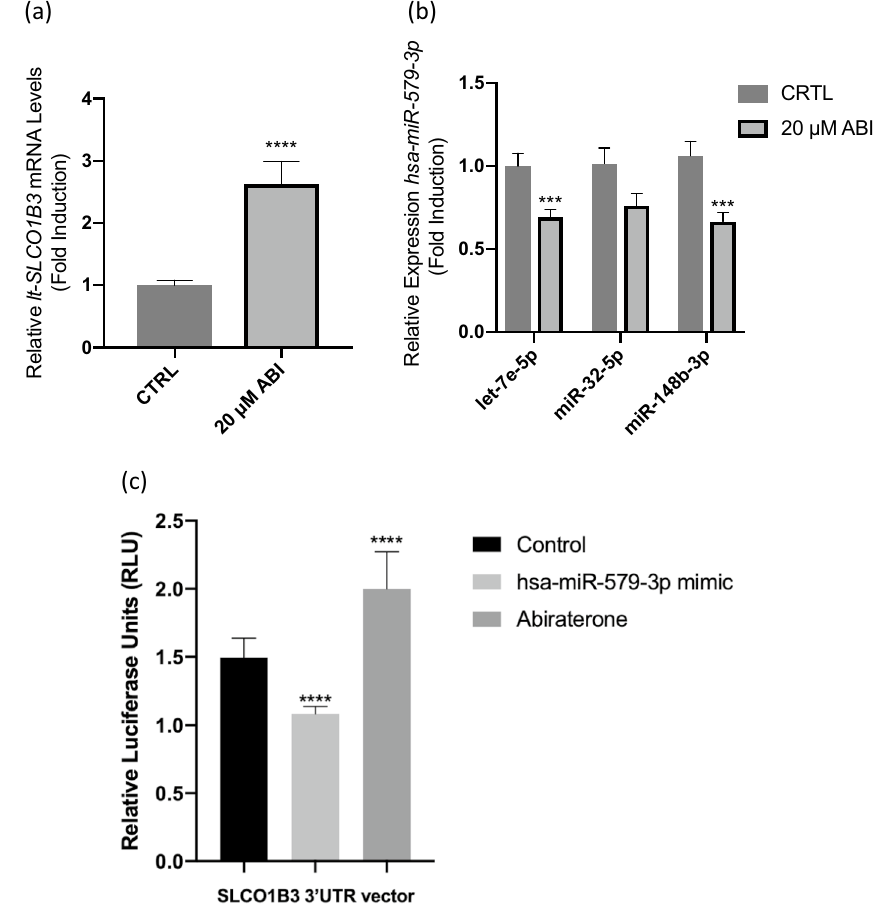
Figure 5. Abiraterone induces overexpression of lt-SLCO1B3 while suppressing hsa-miR-579-5p expression. Effects of abiraterone treatment on the expression of ( a ) lt-SLCO1B3 and ( b ) hsa-miR-579-3p in the samples processed for NanoString analysis were validated by qPCR analysis. As expected hsa-miR-579-3p expression was reduced and lt-SLCO1B3 expression was increased following abiraterone treatment, consistent with miRNA- transcript repression. ( c ) hsa-miR-579-3p directly binds to SLCO1B3 3 ′ UTR. Co-transfection of 22Rv1 cells was performed with the 3 ′ UTR reporter plasmid (or vector control plasmid) and hsa-miR-579-3p mimic (or negative control mimic) for 24 h followed by luciferase reporter assays. The assay revealed a significant decrease in SLCO1B3 reporter activity in the presence of the mimic. 22Rv1 cells were also transfected with the 3 ′ UTR plasmid (or vector control plasmid) followed by treatment with 20 µM Abiraterone (or vehicle DMSO control) for 24 h. Abiraterone treatment resulted in an increase in SLCO1B3 luciferase reporter activity. No significant change was observed in the vector control plasmid lacking the 3 ′ UTR (see Supplementary Fig. S4). These data are the results of three independent experiments performed in triplicates. ***P < 0.005, ****P <